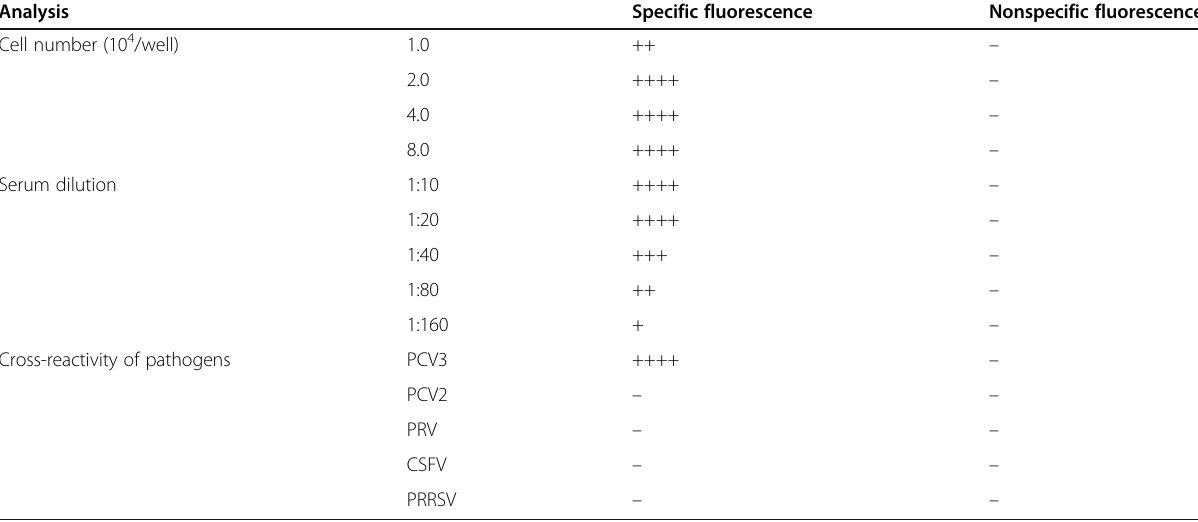
Table 1 Fluorescent observations of different treatments Analysis Specific